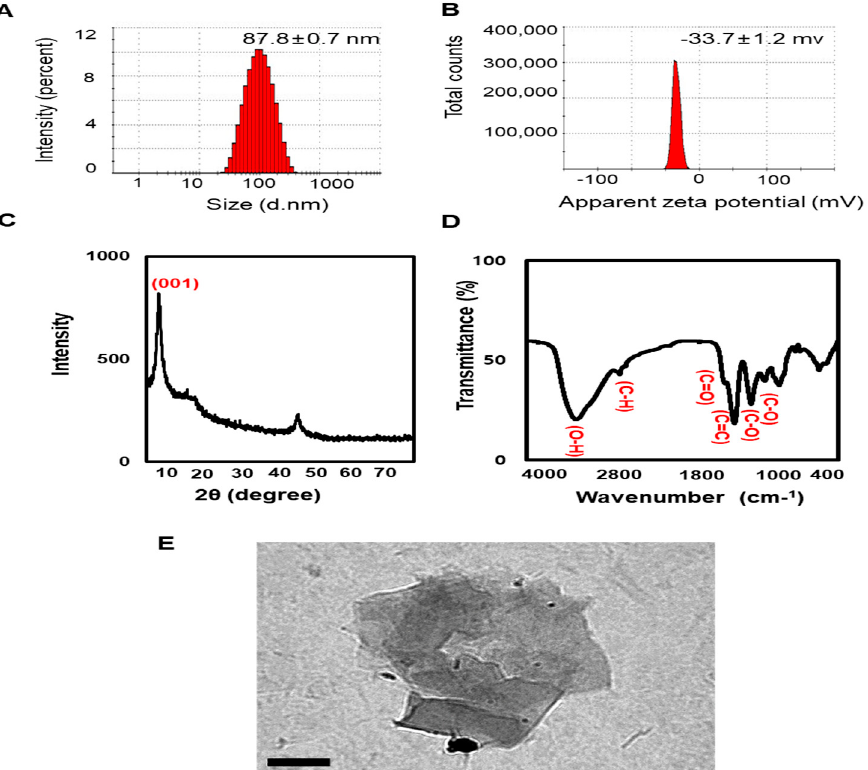
Figure 1. Physicochemical characterization of Nano-GO. Zetasizer showing the size distribution ( A ) and zeta potential ( B ) of Nano-GO. ( C ) Representative XRD pattern of Nano-GO. ( D ) FTIR spectra of Nano-GO. ( E ) TEM images of Nano-GO (scale bar; 200 nm).